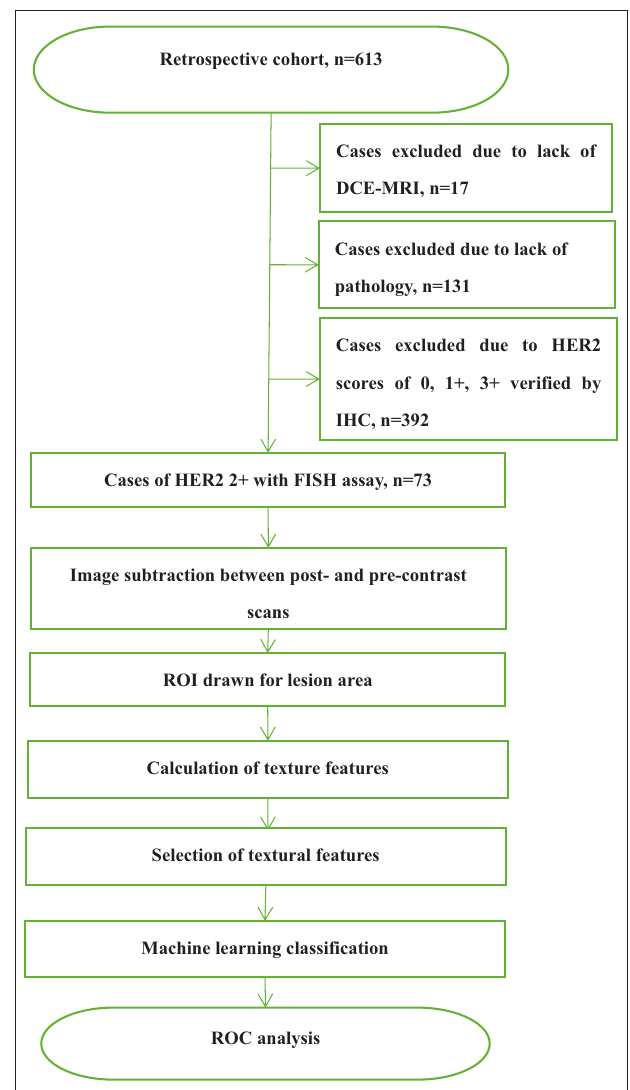
FIGURE 1 | Flowchart of the methods for determination of HER2 2 + status based on texture analysis.